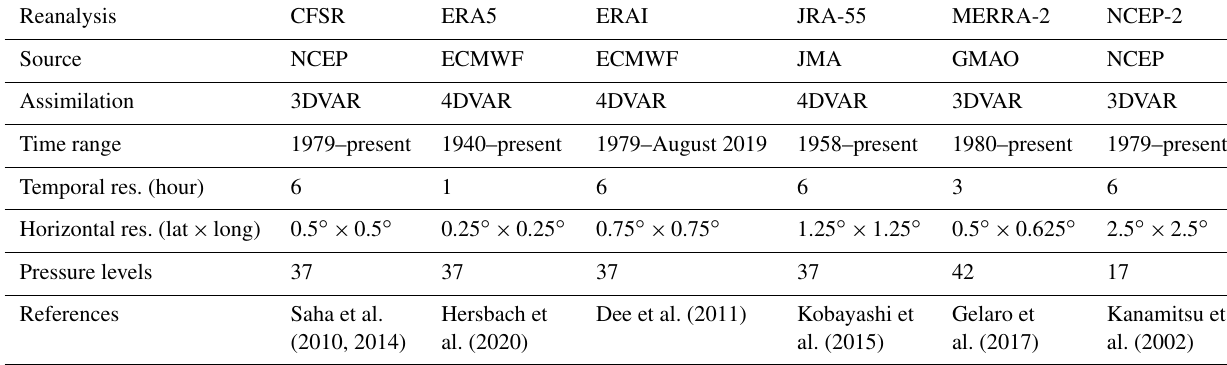
Table 1. Six atmospheric reanalyses used in this study and their characteristics.